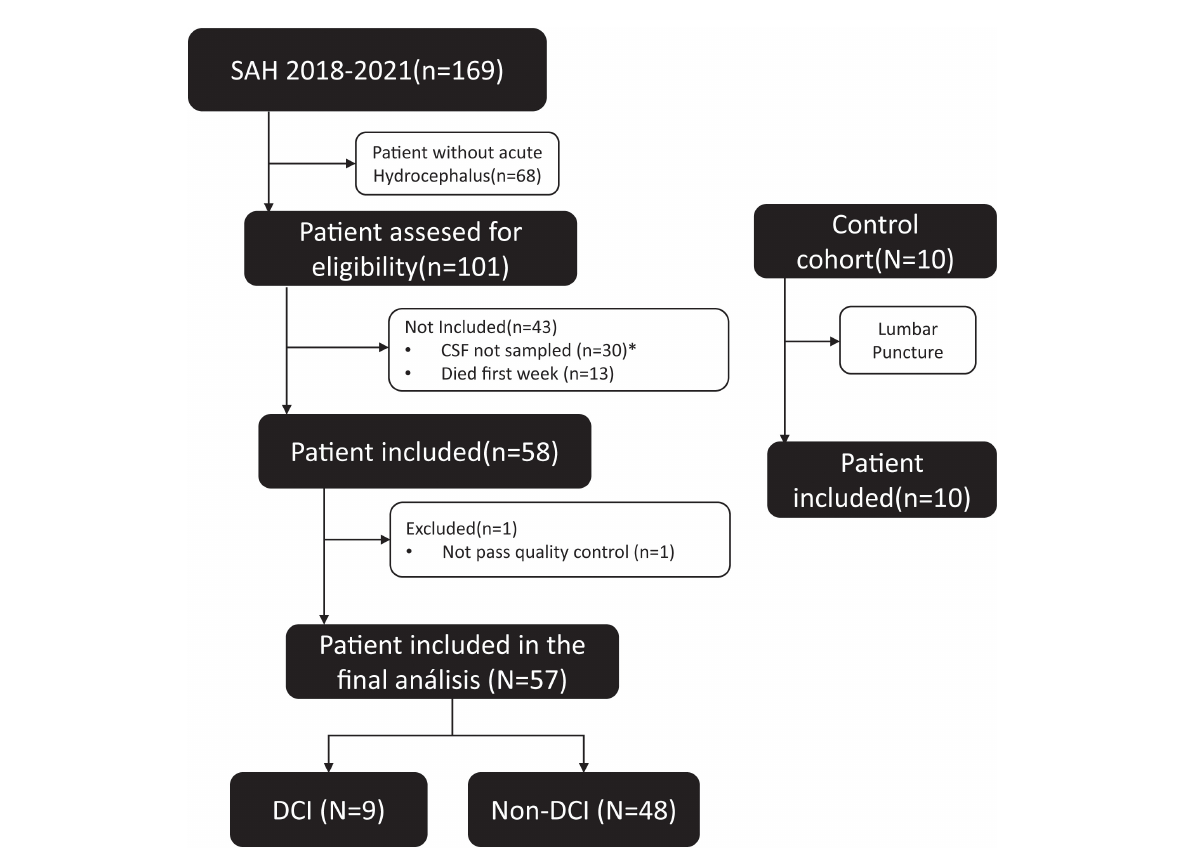
FIGURE1 Clinical algorithm of aSAH patients included in the study. *The amount of sample was not sufficient or had not enough quality to extract the RNA, according to the